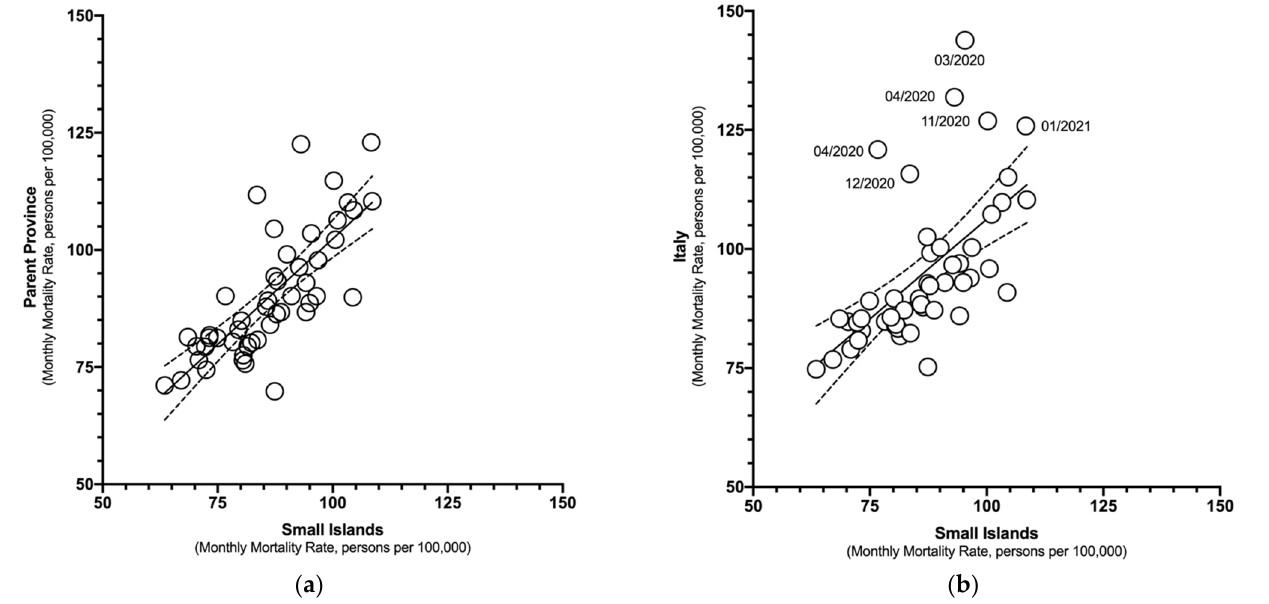
Figure 2. Correlation between monthly mortality estimates for Italian small islands and ( a ) parent provinces (January 2015–December 2021) (Spearman’s rank test rho = 0.783, p < 0.001); ( b ) Italy as a whole (Spearman’s rank test rho = 0.728, p < 0.001).